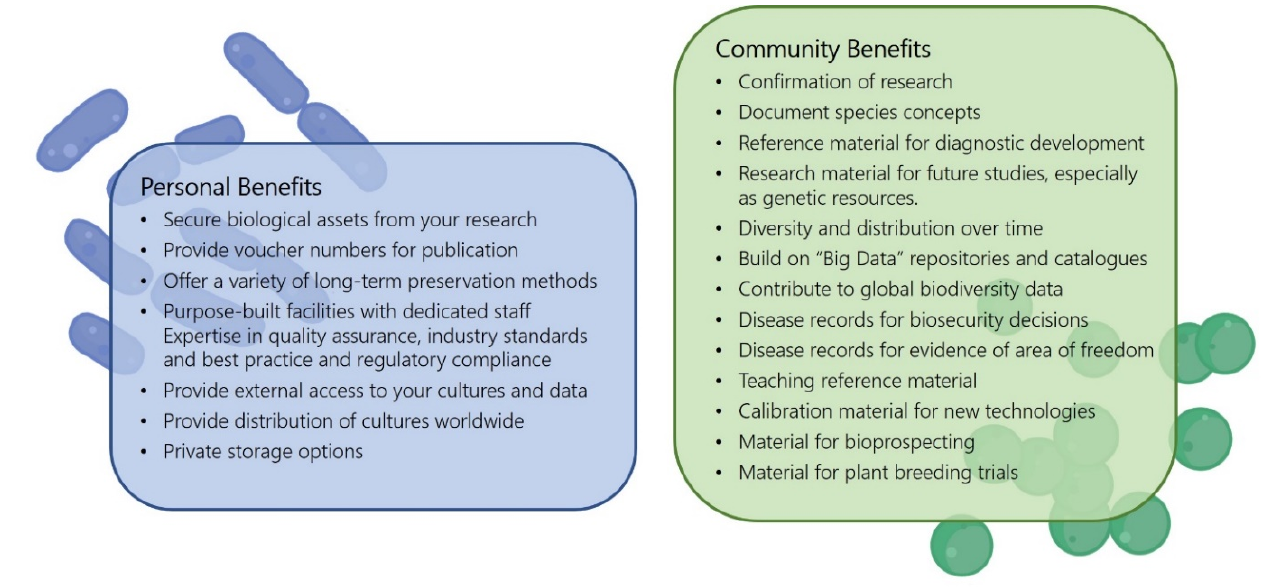
Figure 4. Benefits of depositing strains as based on what we learned from the case